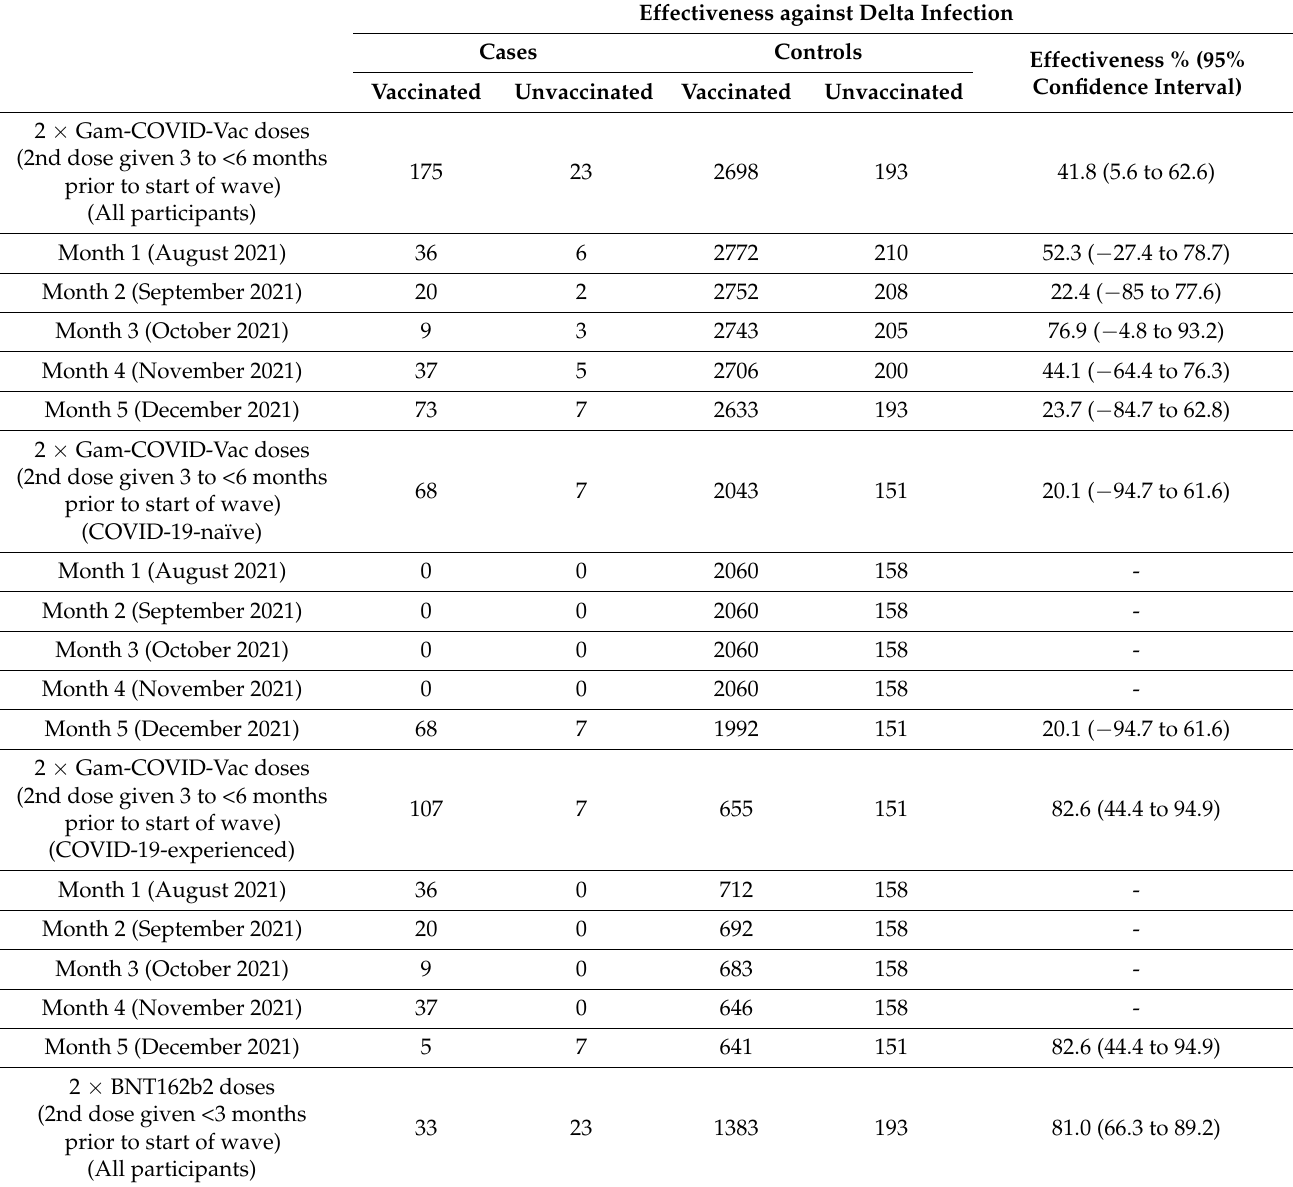
Table 1. Effectiveness of the available COVID-19 vaccination schemes during the Delta wave. Effectiveness against Delta Infection Cases Controls Effectiveness % (95% Confidence Interval)Vaccinated Unvaccinated Vaccinated